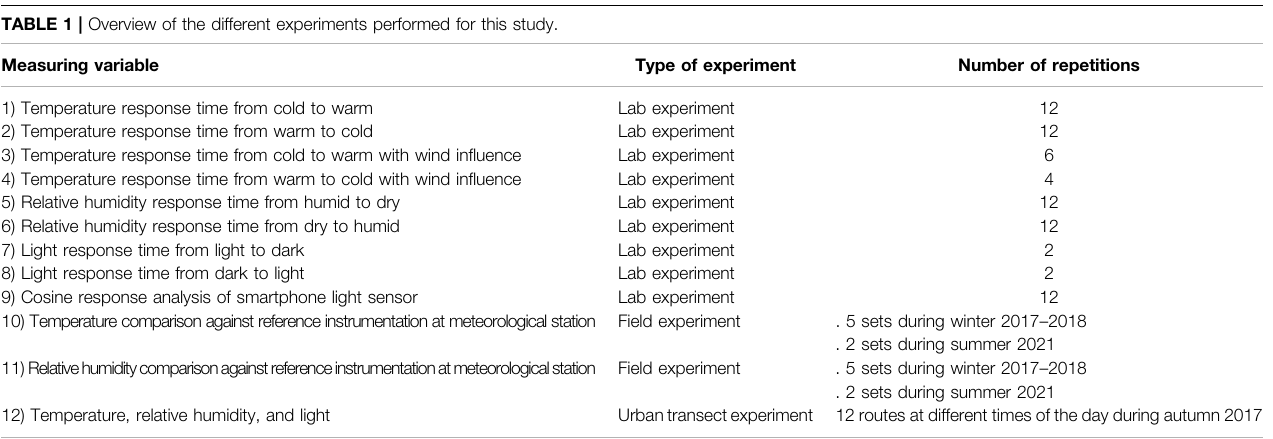
TABLE 1 | Overview of the different experiments performed for this